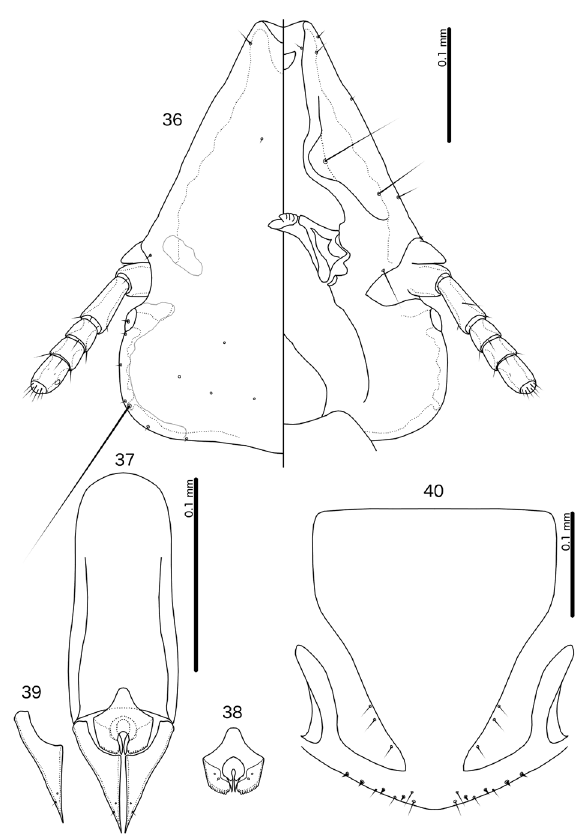
Figures 36–40. Brueelia conocephala (Blagoveshchensky, 1940) ex Sitta europaea (Linnaeus, 1758) 36 Male head, dorsal and ventral views 37 Male genitalia, dorsal view 38 Male me- sosome, ventral view 39 Male paramere, dorsal view 40 Female subgenital plate and vulval margin, ventral